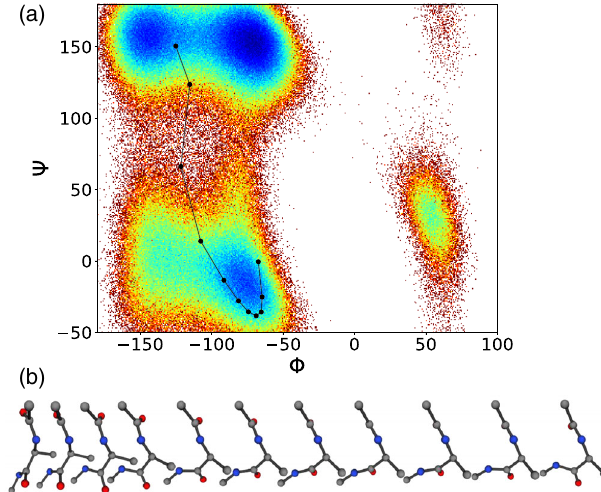
FIG. 6. (a) A path from the molecular configuration at ( − 125 °,150°) to the configuration at ( − 75 °,0°) obtained by spherical linear interpolation of the two slowest latent variables. The background is the probability profile of the alanine dipeptide dataset on the plane of the dihedral angles. (b) The molecular conformation along the interpolation path.